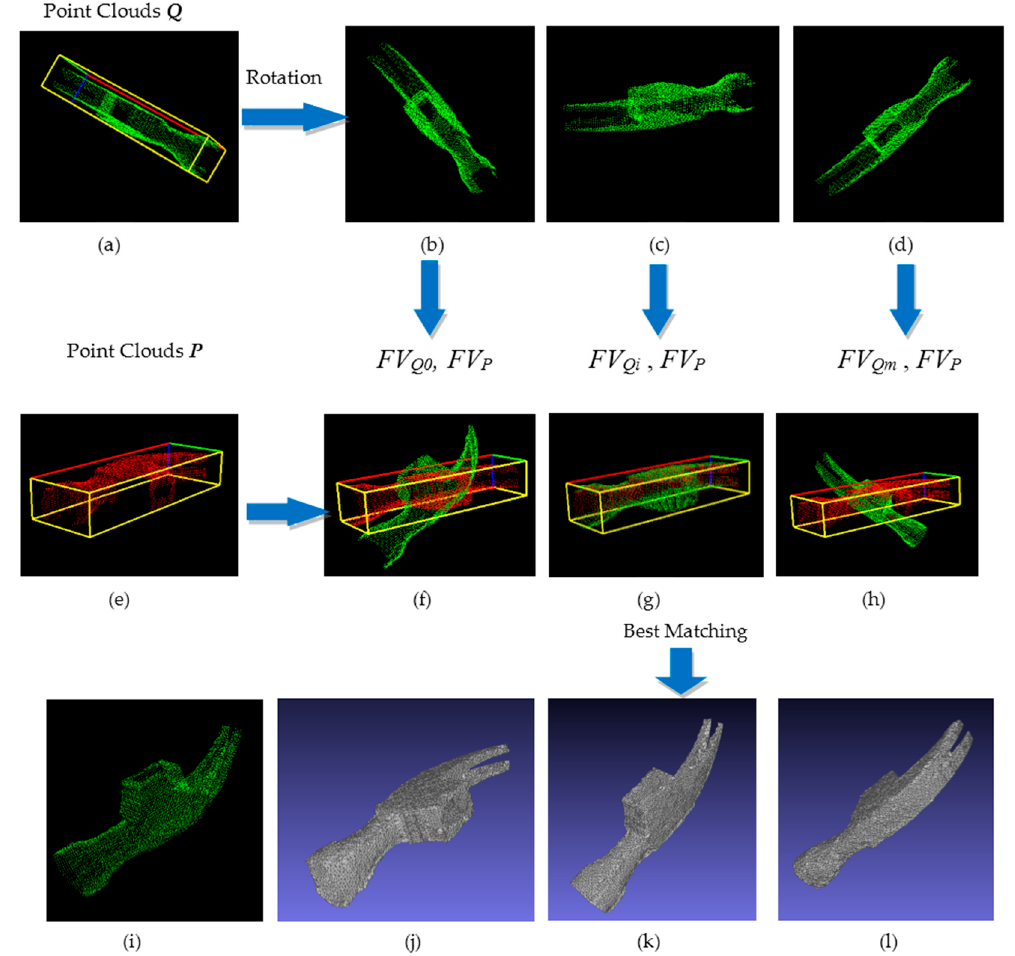
Figure 8. The coarse registration process between series of scans point cloud P and series of scans point cloud Q : ( a ) hammer point cloud Q from the first series of scans; ( b – d ) rotation of point cloud Q ; ( e ) hammer point cloud P from the second series of scans; ( f – h ) the OBB regional area-based descriptor of P and Q ; ( i ) overlap rejected model after refine registration; ( j – l ) the triangle meshes of the hammer head.